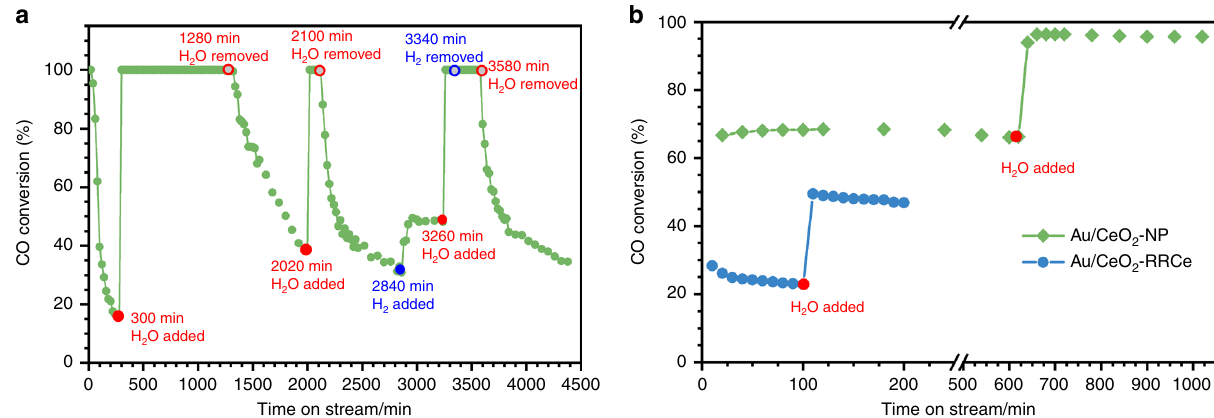
Fig. 1 CO conversion rate as a function of reaction time for CO oxidation at 200 °C. a 0.03 wt% Au 1 /CeO 2 , and b Au/CeO 2 -NP and Au/CeO 2 -RRCe. Reaction condition: 1 vol% CO + 1 vol% O 2 He balance with a fl owrate of 33.3 mLmin − 1 ; 20 mg catalyst was used. The added H 2 O amount was about 2 vol % while H 2 was about